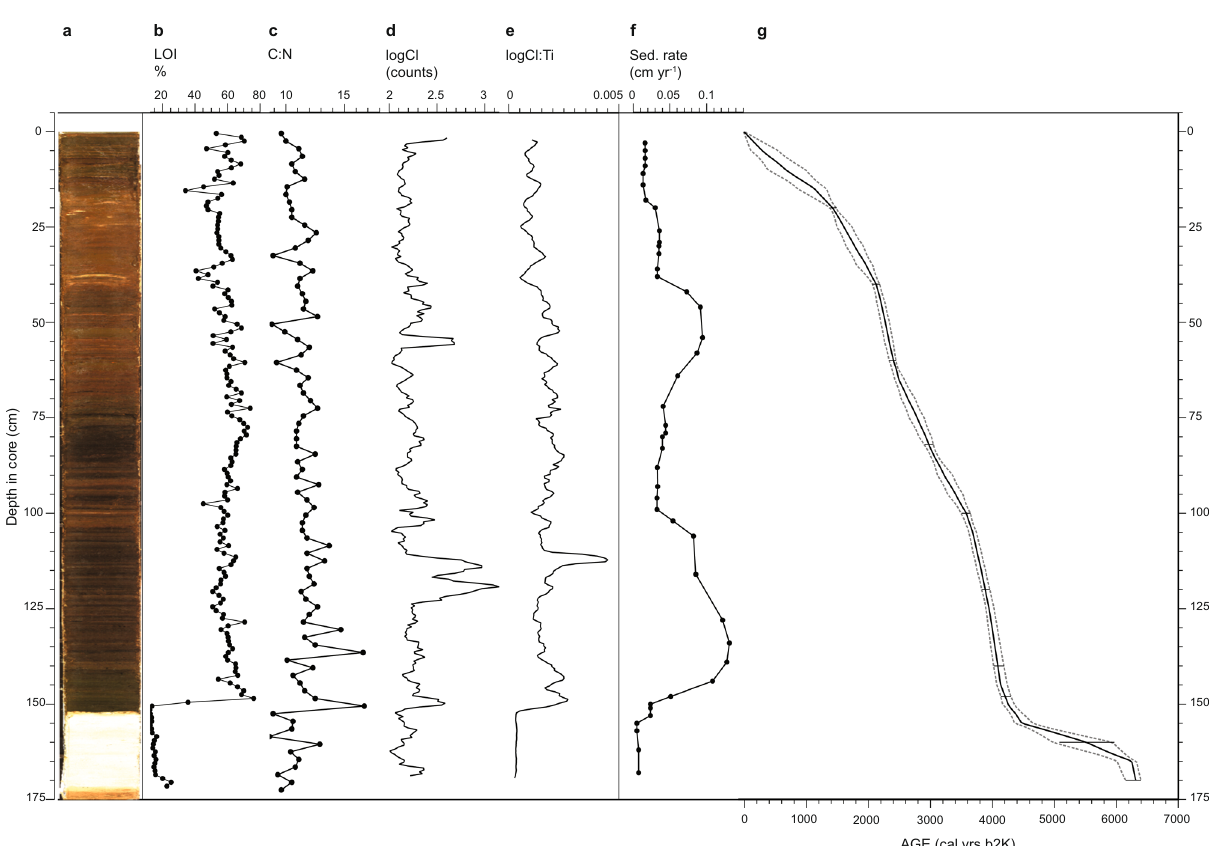
Fig. 3 Lake sediment core. a Core photograph showing laminations and shift from organic-poor to organic-rich sediments at c 150 cm core-depth. b Percentage (weight) of organic material loss on ignition (LOI). c Carbon to Nitrogen ratio (C:N). d Log of Cl counts based on X-ray fl uorescence (XRF) scanning. e Log Cl:Ti XRF data. f Sedimentation rates. g Modelled median age-depth relationship constructed in BACON. Error bars and dashed lines represent modelled 95% con fi dence intervals (for dates see Supplementary Table